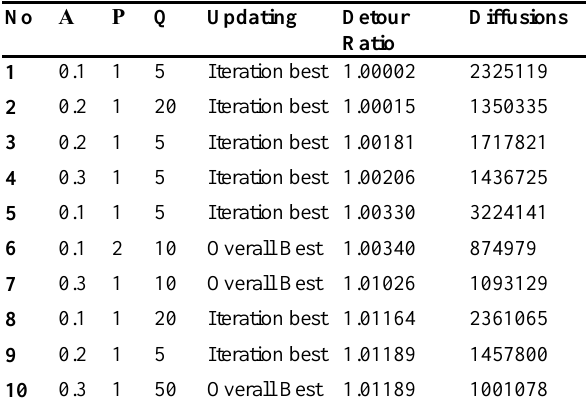
Table 4. The best 20 result with respect to Detour